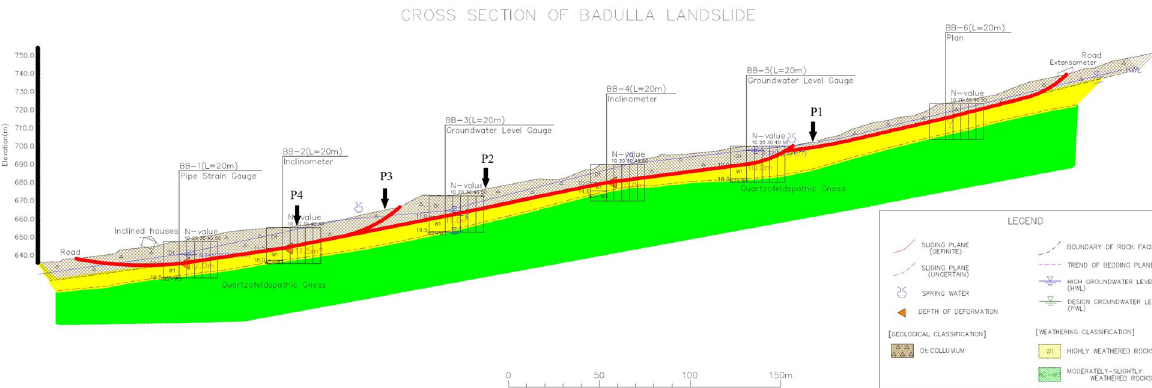
Fig. 13 Borehole-derived geological cross section of the landslide (Landslide Research & Risk Management Division,